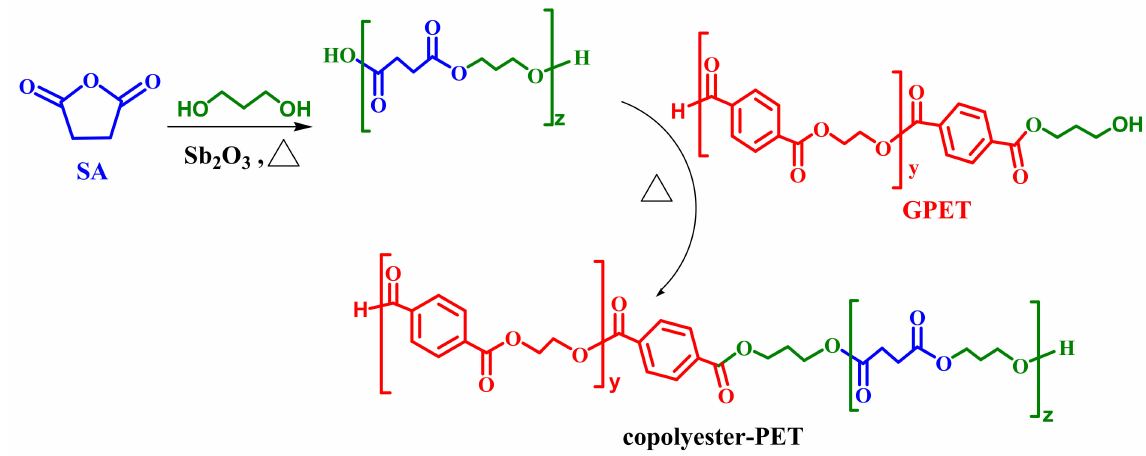
Figure 3. Reaction scheme of the co-polyester